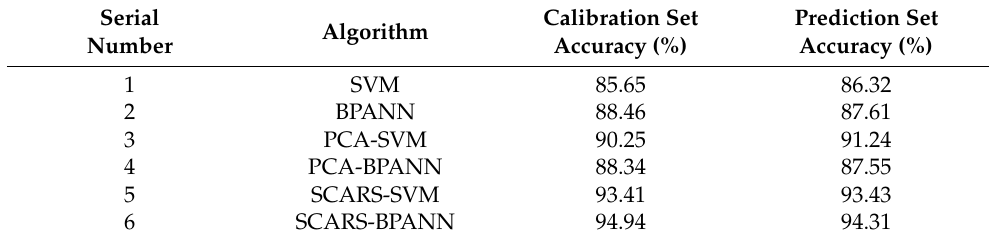
Table 2. Accuracy statistics of spore classification